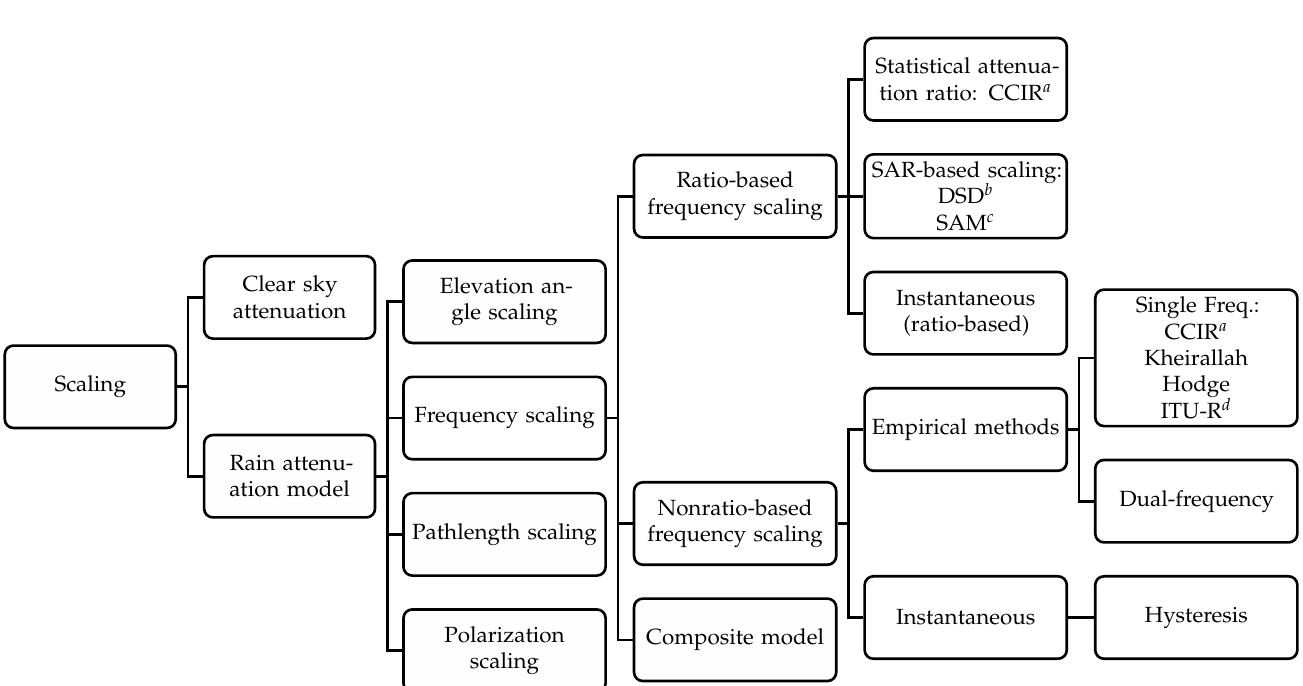
Figure 1. Rain attenuation scaling taxonomy. Note: a CCIR: Comité Consultatif International des Radiocommunications, b DSD: (rain) raindrop size distribution, c SAM: simple atmospheric model, d ITU-R: International Telecommunication Union-Radiocommunication